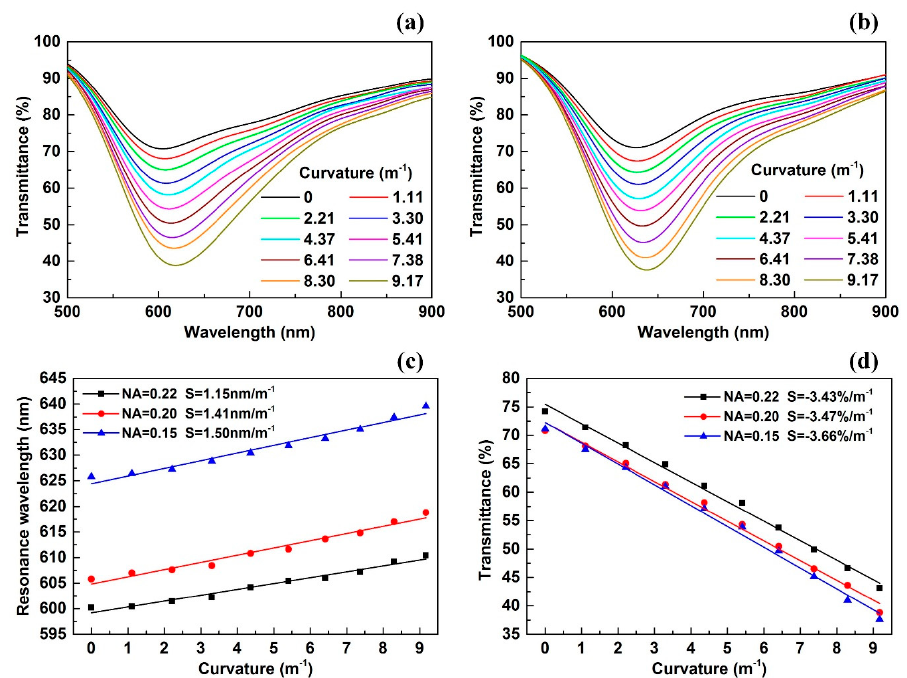
Figure 6. ( a ) The transmitted spectrum changing with curvature when fiber NA = 0.20; ( b ) the transmitted spectrum changing with curvature when fiber NA = 0.15; ( c ) comparison of the resonance wavelength variation under different fiber NAs; ( d ) comparison of the transmittance variation under different fiber NAs.